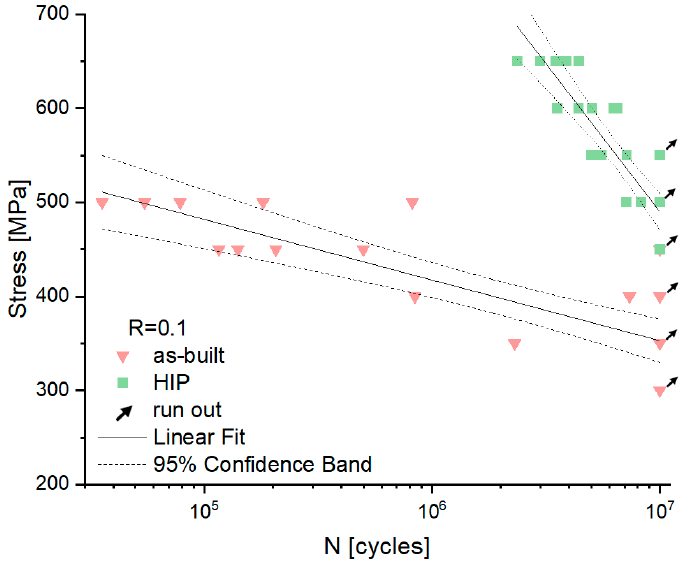
Figure 14. S–N curve fatigue results—relationship between the applied stress and the number of cycles to failure of the as-built, HIP specimens. Solid lines present regression fit, dotted lines present 95% confidence bounds from regression fit.